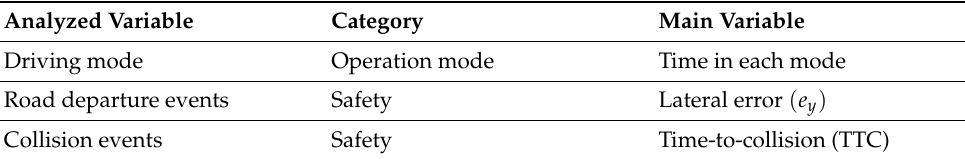
Table 2. Variables for statistical analysis of objective results.